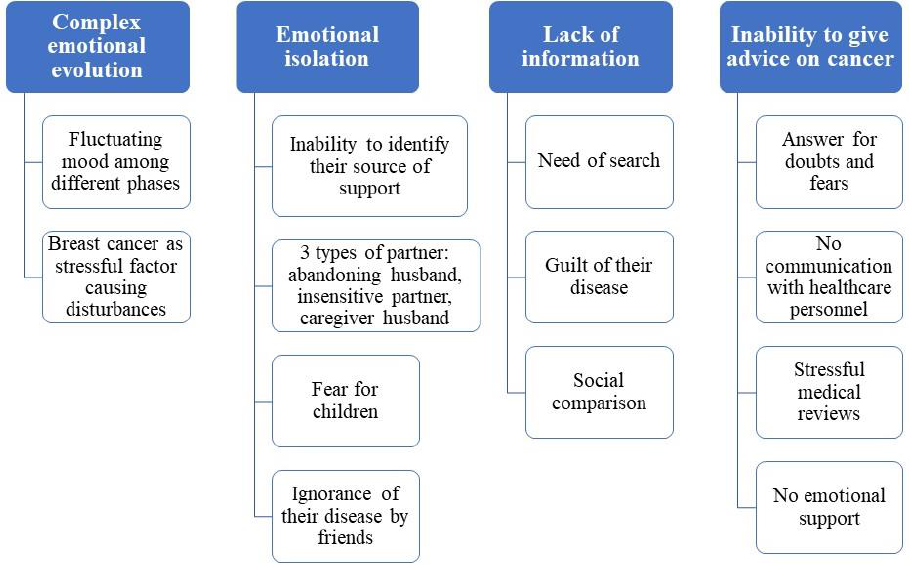
Figure 1. A framework of the themes and subthemes discussed.